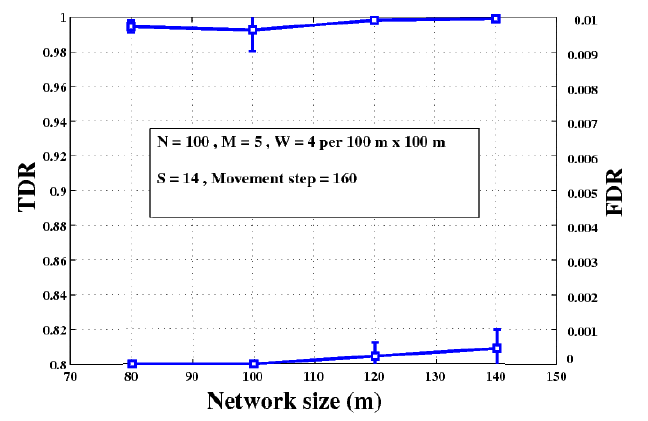
Figure 11. Scalability evaluation of the proposed